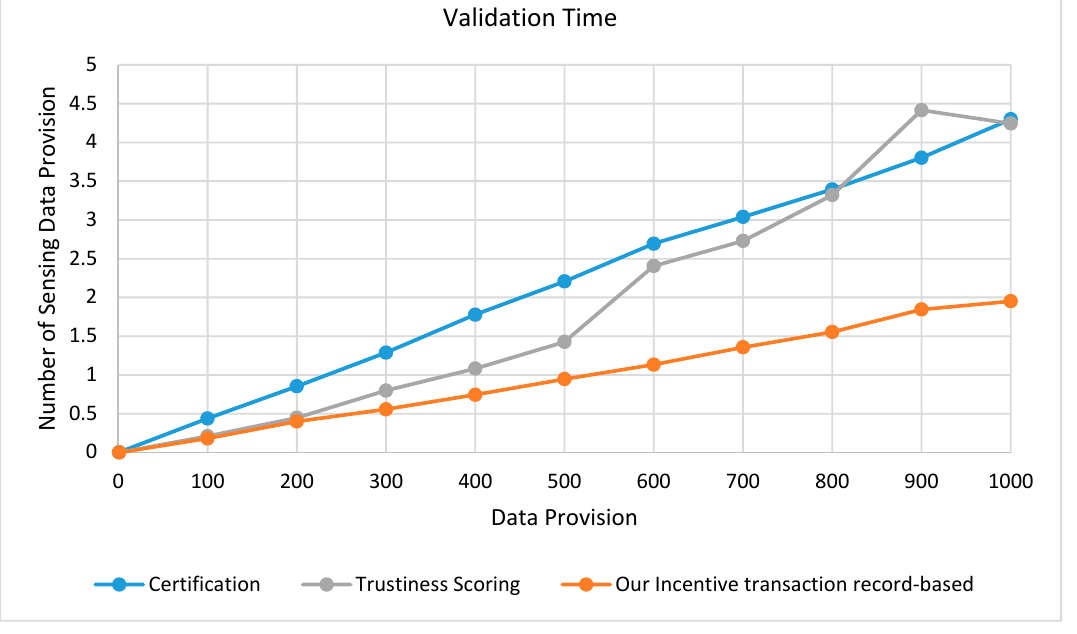
Figure 12. Validation time.